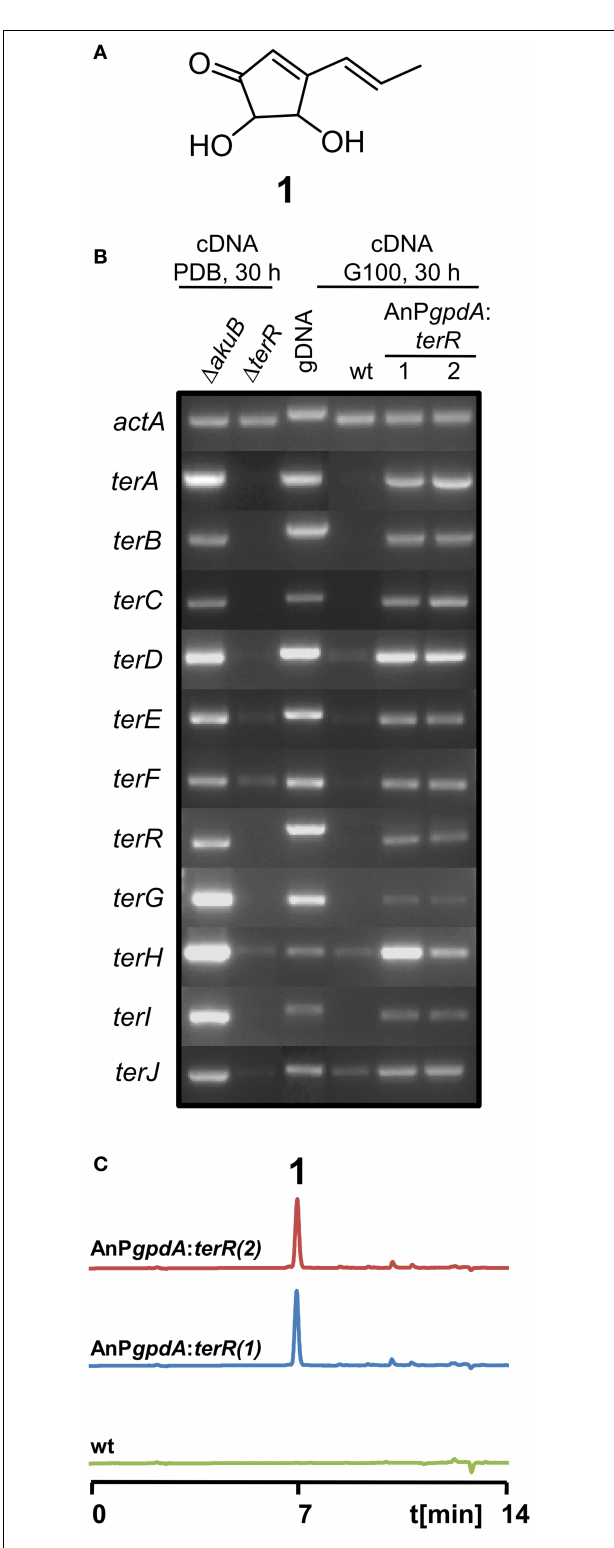
FIGURE 1 | Analysis of terrein cluster induction in dependence of terR expression. (A) Chemical structure of terrein (1). (B) Semiquantitative RT-PCR